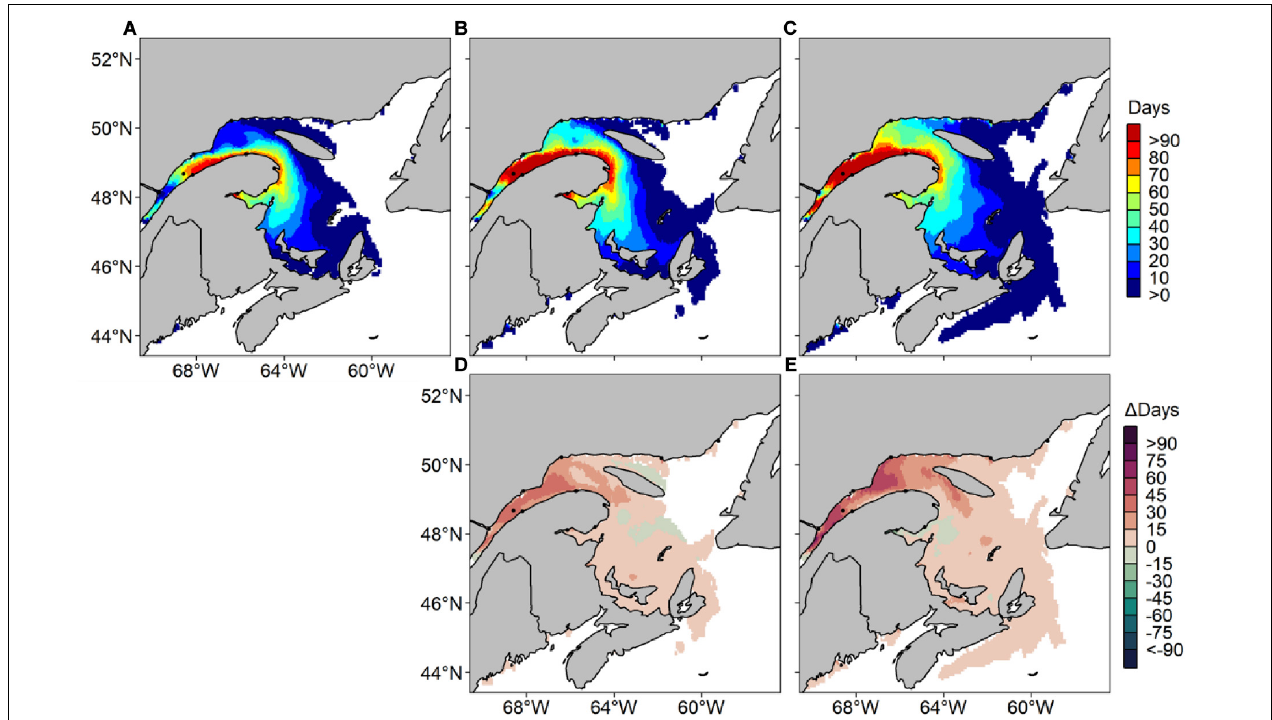
FIGURE 7 | Average number of risk days with Alexandrium catenella ≥ 1000 cells L − 1 from May through October along Canada’s East coast under MPI-ESM-LR RCP 8.5 for (A) 1999-2008, (B) 2050–2059, (C) 2090–2099 and difference in average number of risk days between (D) 1999–2008 and 2050–2059 and